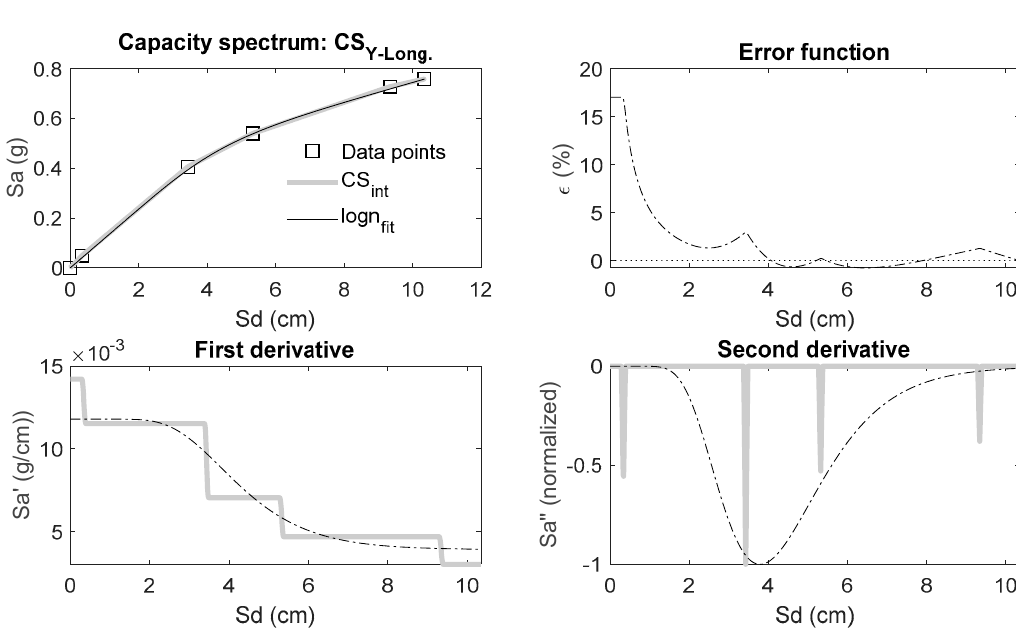
Figure 10. Parametric model fit in the Y-direction.